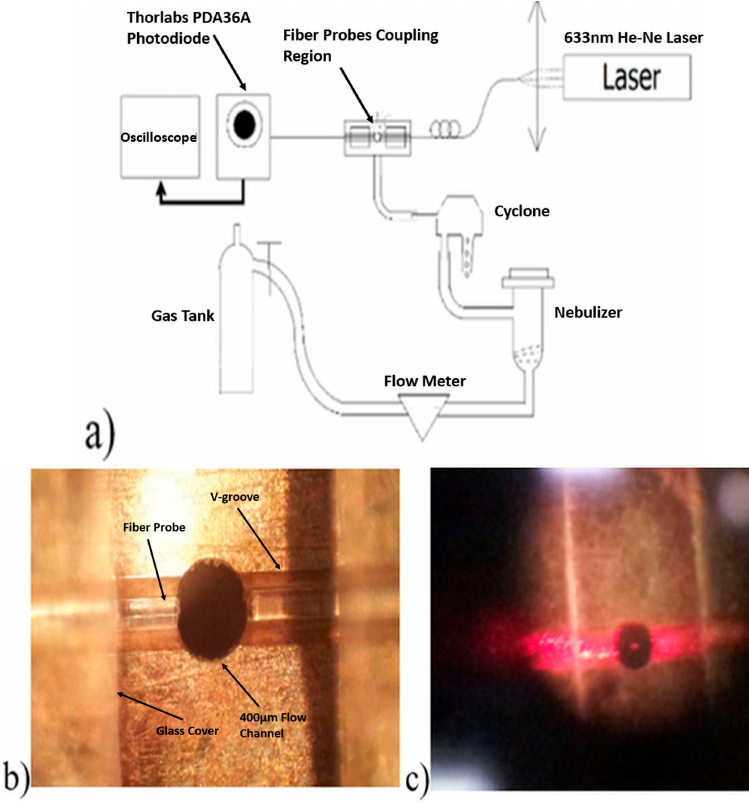
Figure 4. ( a ) Experimental setup allowing generation and size segregation of particles, ( b ) fiber probes in the V-groove holder with 400 µm separation, ( c ) picture taken during experiment, where a low flow rate and large particles are used to enable the scattered light from the particles to be seen. The signal from the receiving probe was detected by a Thorlabs PDA36A photodiode. A digitizing oscilloscope was connected to the photodiode to show the waveform captured by it. Since the air flow contains a variety of particles with sizes below the cut-off size, for each flow rate, the largest excursion was caused by particles of the maximum size being near the center between the fibers (position 0,0). The percentage of coupling energy drop for a certain sized particle was determined by dividing the amplitude of the largest downward spike by the average amplitude of the signal on the oscilloscope’s output waveform.